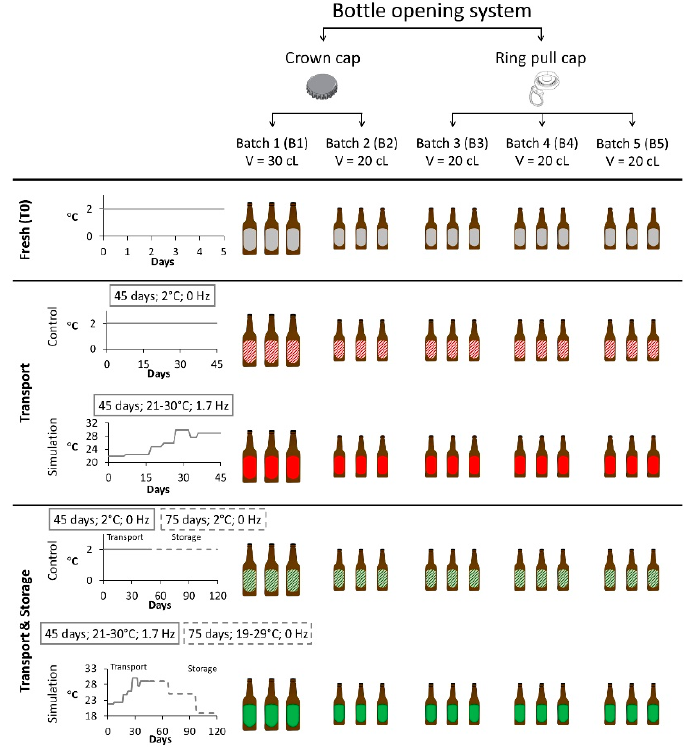
Figure 7. Overview of the experimental design to simulate maritime transport and storage condi-